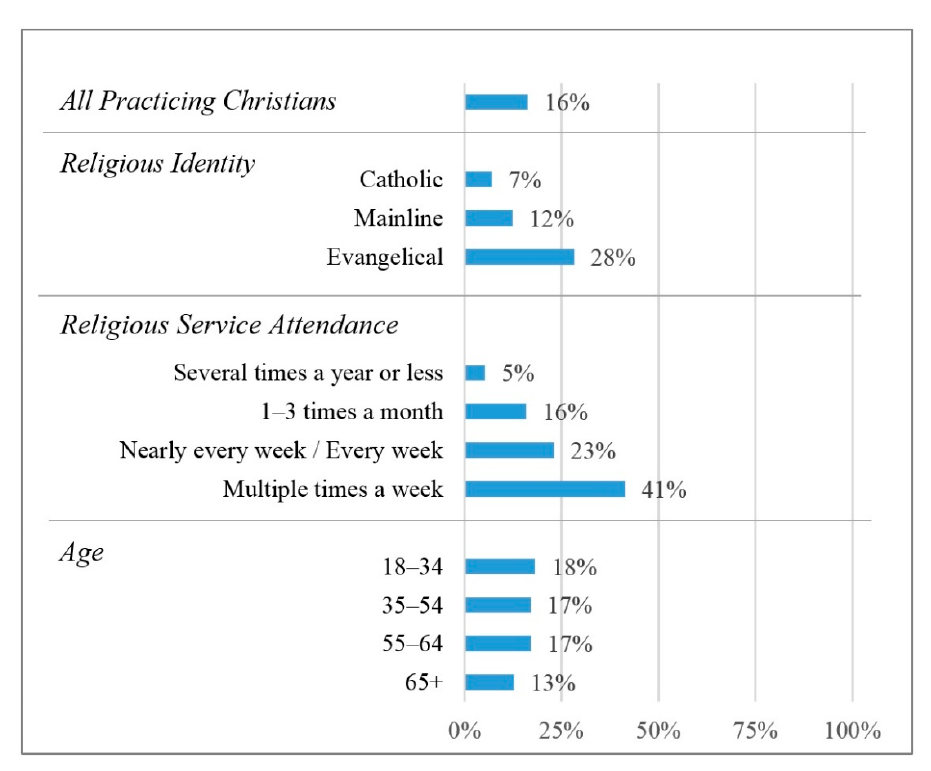
Figure 3. % of people who say they do not participate in discussion groups about faith and work (overall and by subgroup).